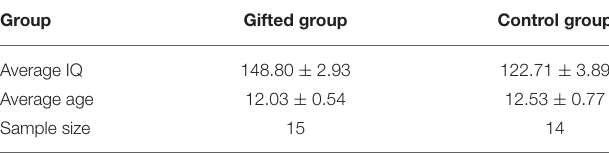
TABLE 1 | Membership information of gifted children MRI